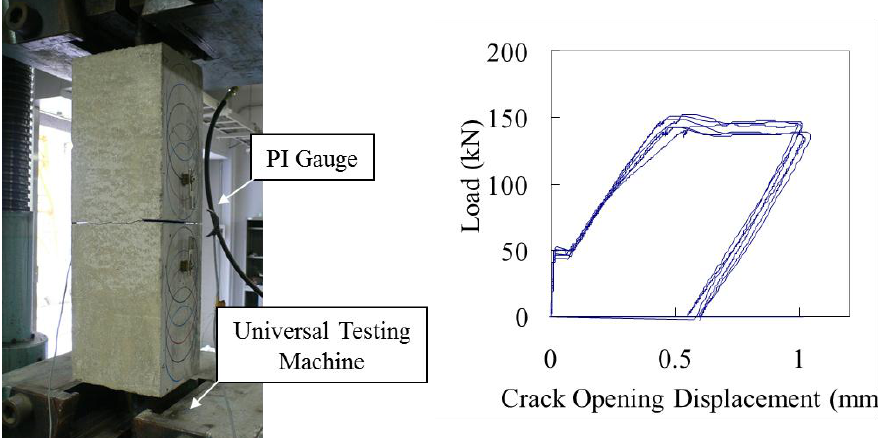
Figure 2. Experimental setup and load-displacement